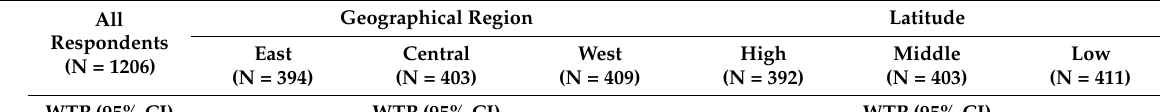
Table 4. Parents’ willingness to pay for the attributes of influenza